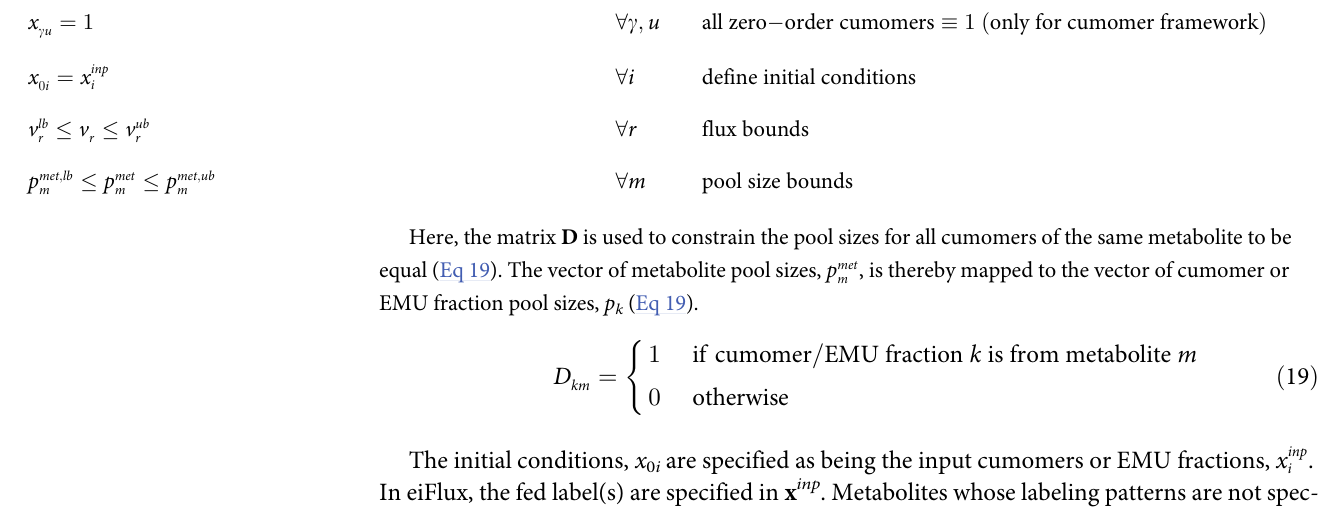
Here, the matrix D is used to constrain the pool sizes for all cumomers of the same metabolite to be EMU fraction pool sizes, p (Eq k